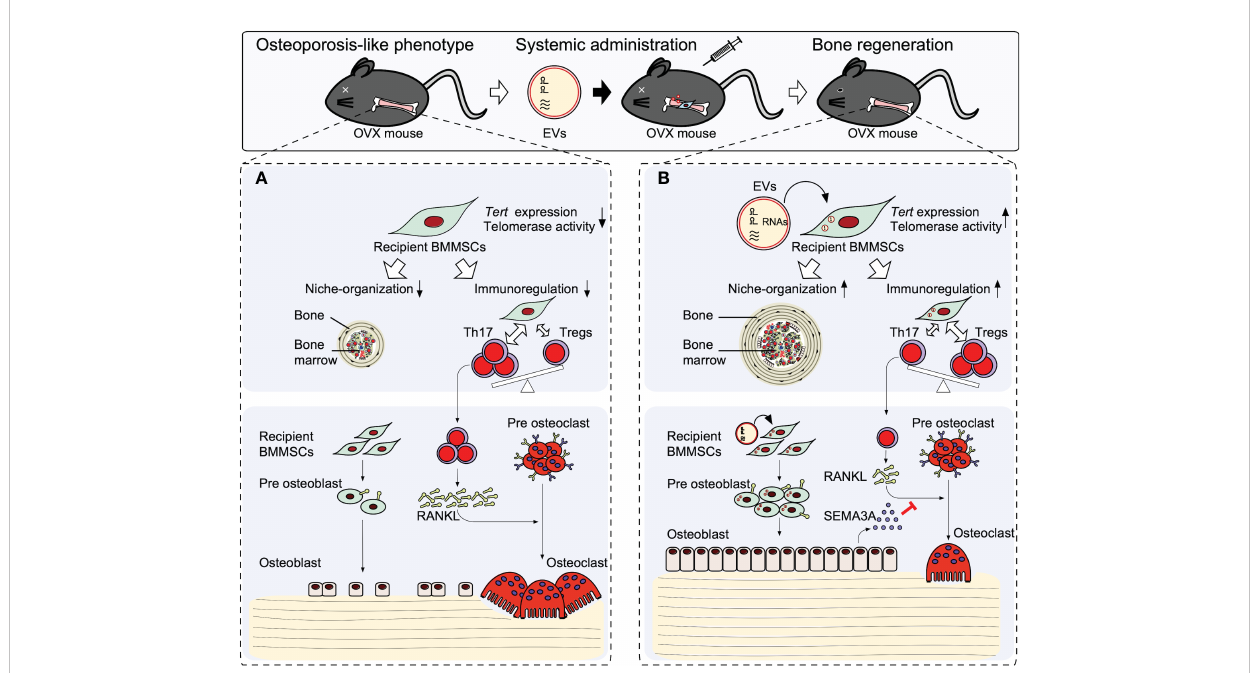
FIGURE 2 Therapeutic effects of stem cells from human exfoliated deciduous teeth releasing extracellular vesicles (SHED-EVs) on osteopenia model mice. Systemic administration of SHED-EV ameliorates osteopenia phenotype. (A) In osteopenia bone marrow, recipient BMMSCs exhibit an impaired microenvironmental modulating function including bone marrow-like niche formation and immunosuppressive regulation associated with the reduction of telomerase reverse transcriptase ( Tert ) gene expression and telomerase activity. The impaired recipient BMMSCs causes the direct suppression of osteogenesis and induced osteoclast differentiation via activated Th17 cells, resulting in causing bone loss. (B) Systemic administrated SHED-EVs transfer RNA contents into recipient BMMSCs. Mechanistically, RNA contents within SHED-EVs epigenetically enhance the telomerase reverse transcriptase gene ( Tert ) expression and telomerase activity in recipient BMMSCs. Finally, the activated telomerase activity rejuvenates the environmental modulating function of recipient BMMSCs, subsequently recover the impaired osteogenesis and semaphoring 3A (SEMA3A) releasing of recipient BMMSCs. The upregulated SEMA3A inhibit osteoclast differentiation via receptor activator of nuclear factor- k B ligand